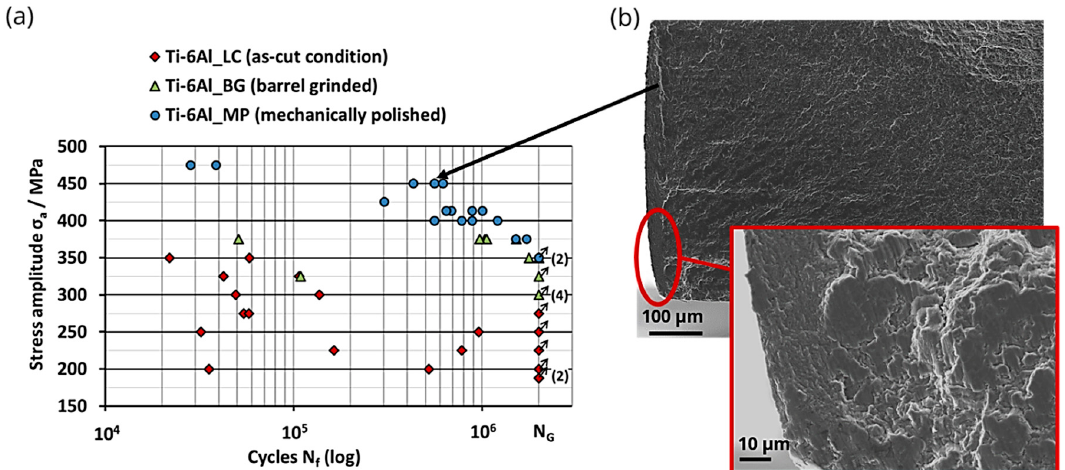
Figure 7. Fatigue results of the Ti-6Al-4V-ELI alloy: ( a ) S-N diagram for all three tested sample series; ( b ) Fracture surface analysis for a Ti-6Al_MP sample with mechanically polished surface conditions including the crack initiation site on the laser-cut edge directly near the sample corner after fatigue failure at 450 MPa and 6.2 × 10 5 cycles.